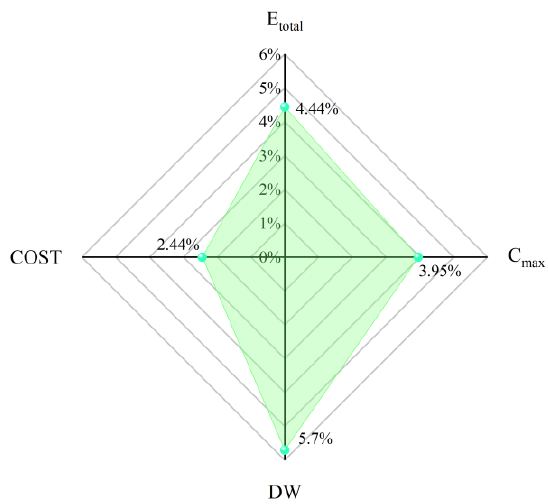
Figure 29. Total impact of the hybrid energy-saving strategy.